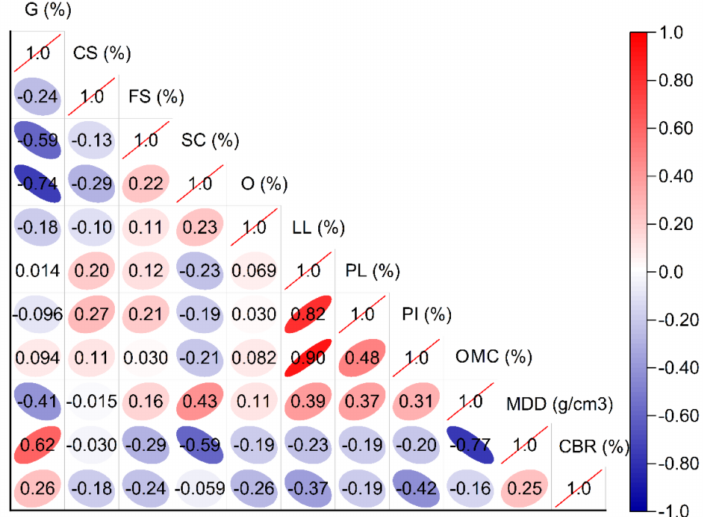
Figure 2. Correlation matrix analysis input variables in this